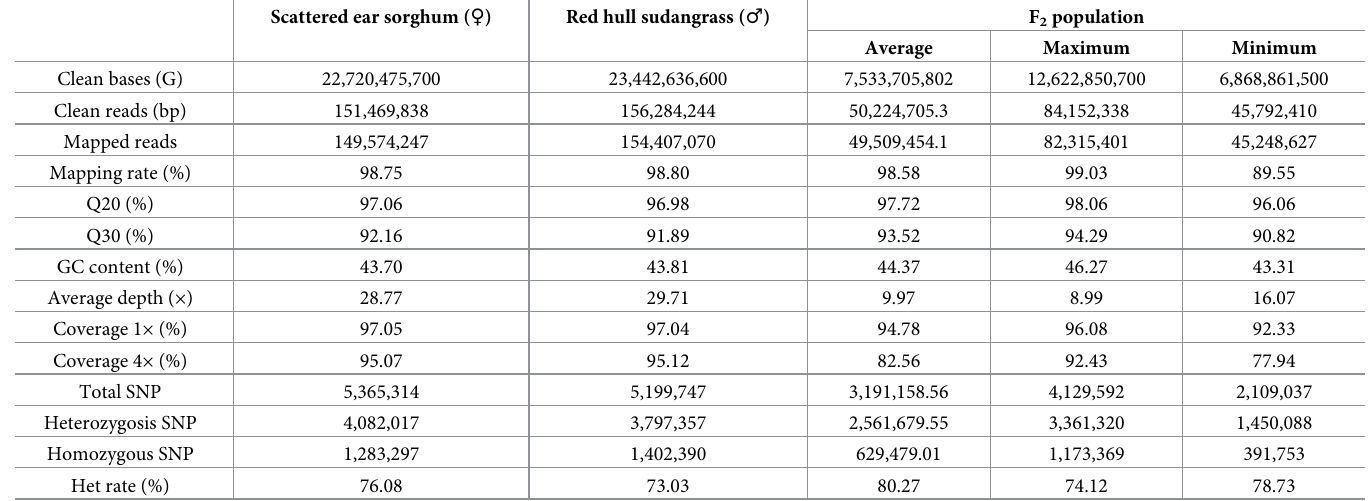
Table 1. Statistics of sequencing data for sorghum-sudangrass hybrid.